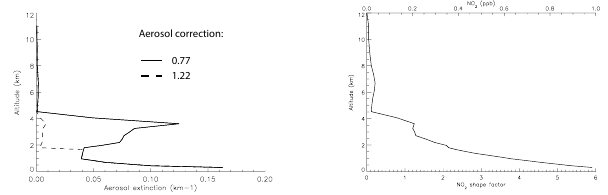
Figure 3. Left: GEOS-Chem aerosol extinction coefficients profile with (solid line) and without (dashed line) the elevated aerosol layer for a single grid cell over West African fires at OMI overpass time (13:30LT). The aerosol correction factor values corresponding to each type of aerosol profile are reported in the figure. Right: GEOS- Chem NO 2 profile shape for the same grid cell.